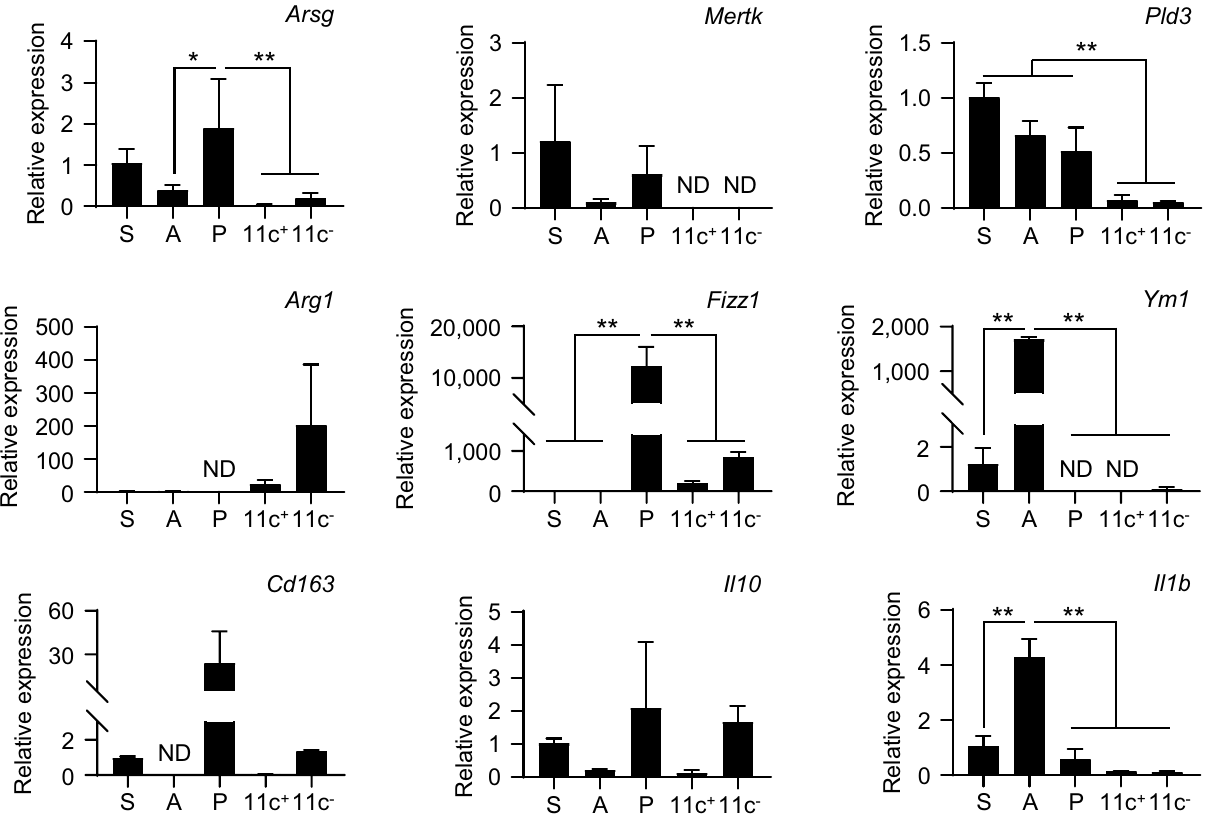
Figure 8. mRNA expression levels of macrophage signature genes in SMG macrophages. Female C57BL/6N mice at 8 weeks old were used. The mRNA expression levels of Arsg , Mertk , Pld3 , Arg1 , Fizz1 , Ym1 , Cd163 , Il10 , and Il1b were analyzed by quantitative RT-PCR. Expression levels were normalized to β-actin levels and expressed as relative expression based on the value of splenic macrophages. Bars represent the mean ± SD (n = 2 or 3). If two or more sets of triplicate samples were lower than detection limit, results were expressed as “not detected (ND)”. S splenic macrophages, A alveolar macrophages, P pancreatic macrophages, 11c + SMG CD11c + macrophages, 11c − SMG CD11c − macrophages. ** P < 0.01, * P < 0.05 by a one-way ANOVA using Tukey’s multiple comparisons